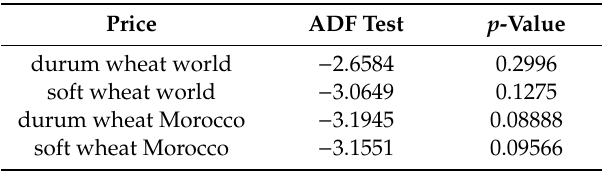
Table 2. Augmented Dickey-Fuller